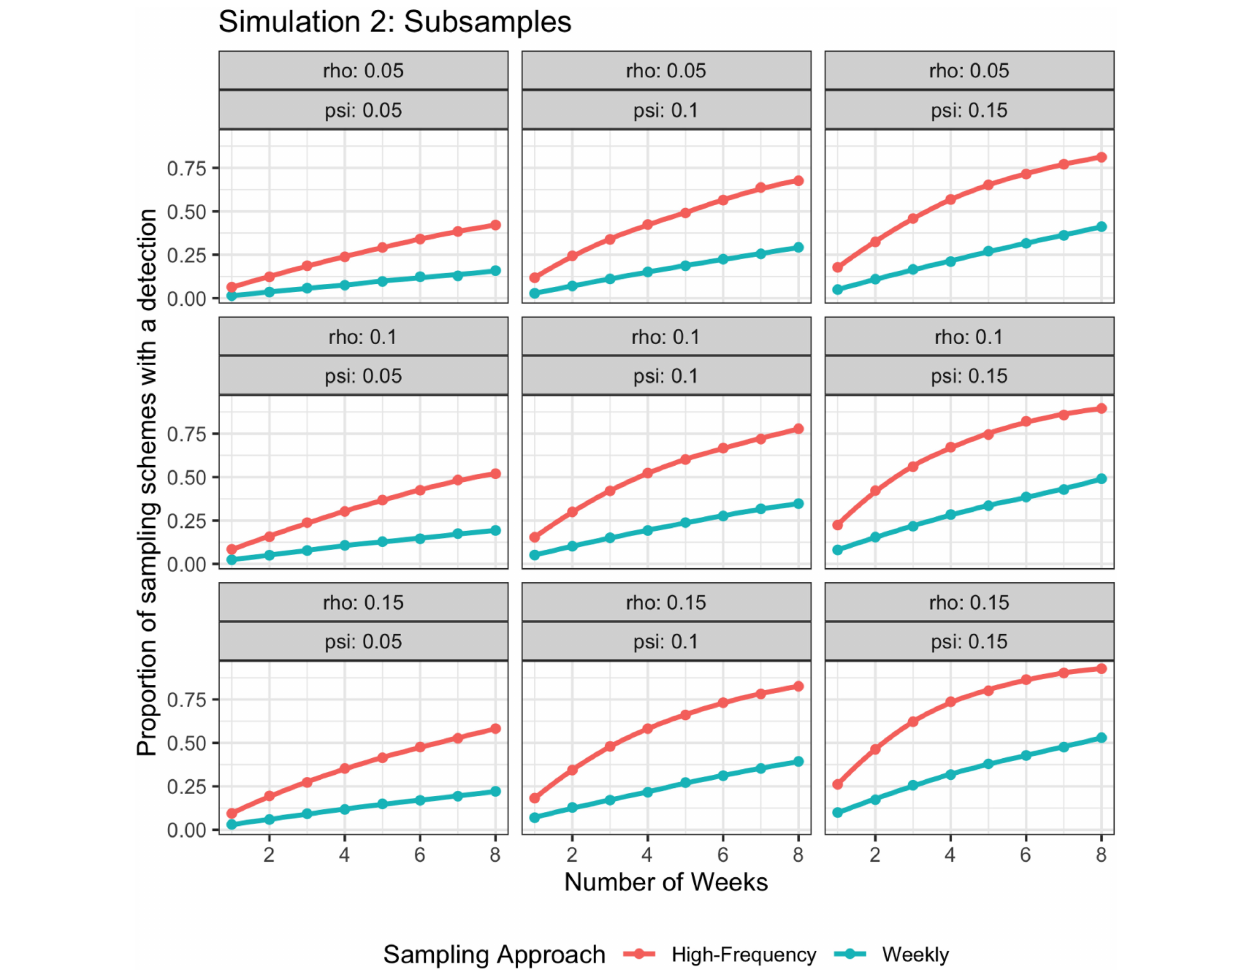
FIGURE 6 | Probability of detection as a function of rho , psi , and number of weeks; rho varies stochastically on a day-to-day basis. The high-frequency approach collects samples daily and the weekly approach takes seven samples once a week. Weekly samples are modeled as non-independent